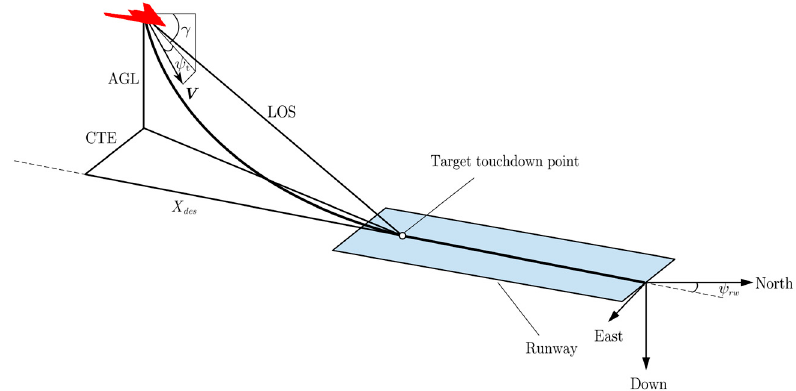
Figure 20. Sink rate and bank angle command calculation.